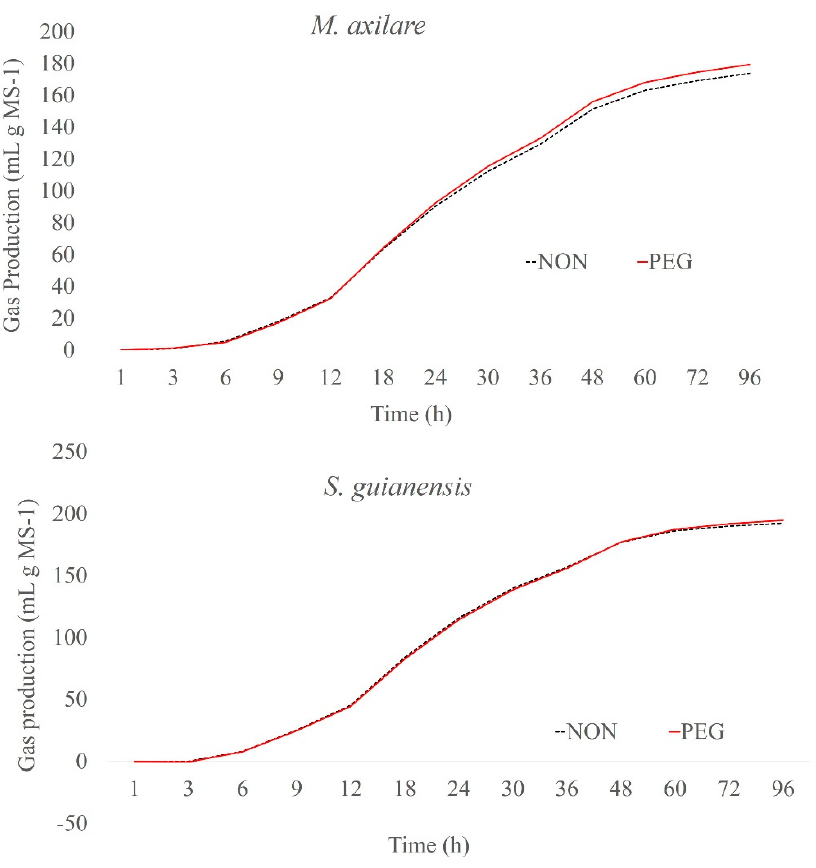
Figure 3. Cumulative gas production curves of Macrotiloma axilare and Stylosanthes guianensis incubated at the end of 96 h.